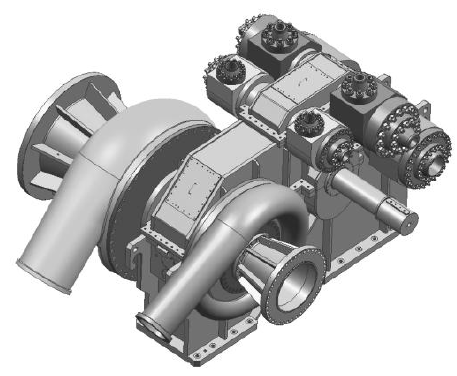
Figure 3. SRL Compression Train pressure-flow rate characteristic curve with variable Inlet Guide Vanes